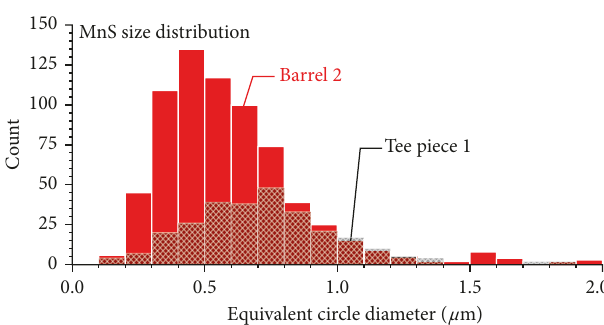
Figure 7: Number density of inclusions for two different but code acceptable Grade 91 steels. A higher density of MnS was measured in the creep damage susceptible steel which contained 0.009wt.% S (labelled barrel 2) as compared to the cavity resistant steel which contained 0.002wt.% S (labelled tee piece 1).